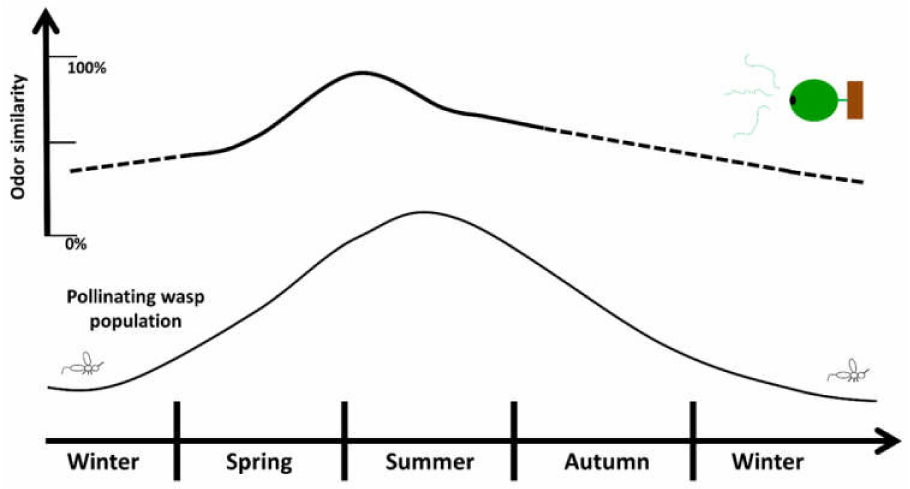
Figure 5. Wasp population and odor similarity trends over a